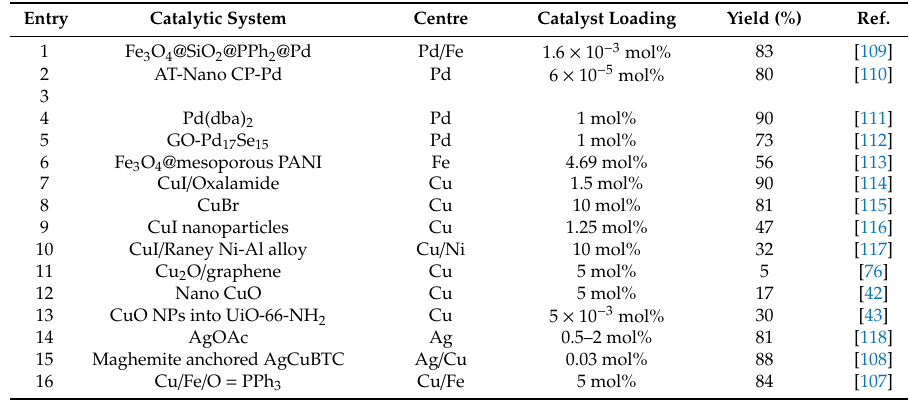
Table 8. The comparison of a single catalyst and with a combined catalyst in the Ullmann O-arylation